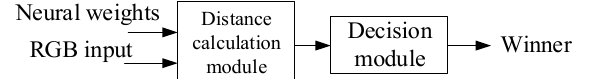
Figure 10. Discrete-event model of the SOM color classification module.